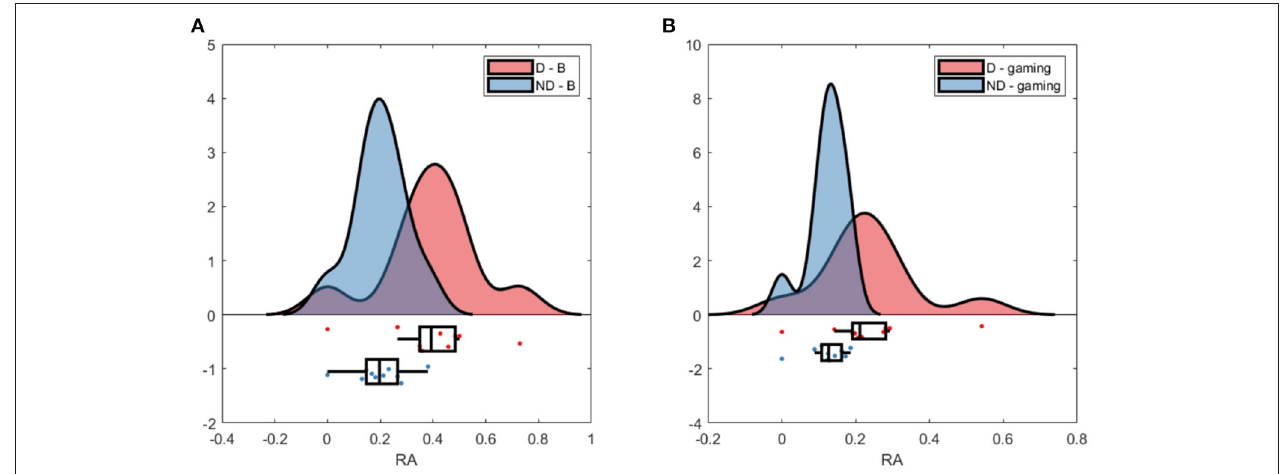
FIGURE 4 | Raincloud plot of relative alpha power at Pz; (A) baseline D (red) and ND (blue); (B) gaming D and ND. Pair 2